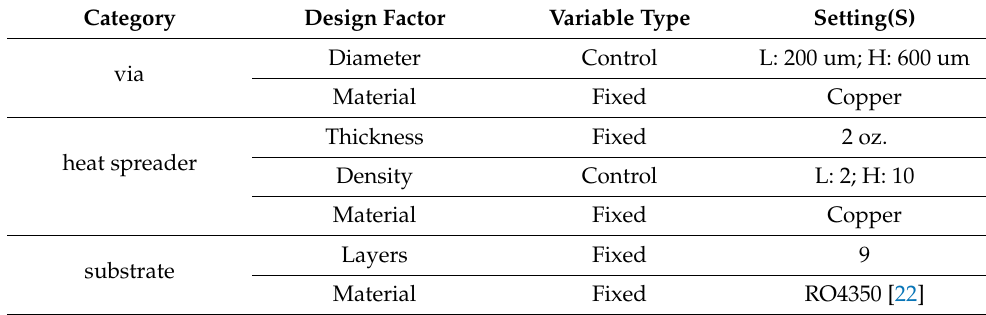
Table 1. Design table for PCB MVA implementation.